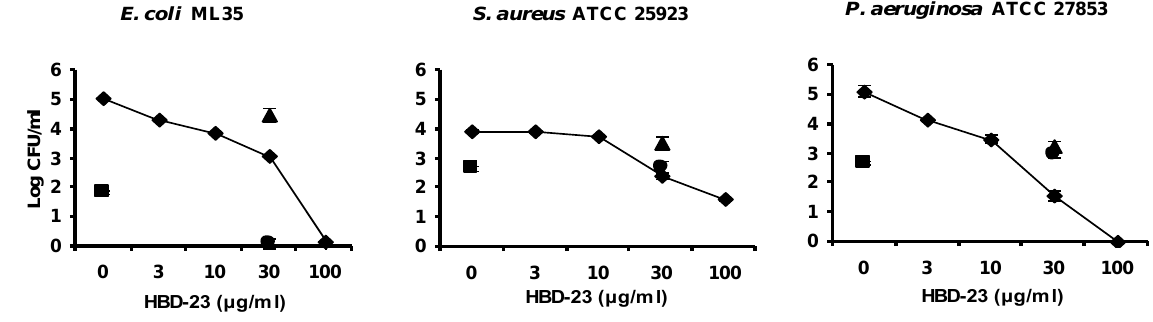
Figure 4. Antimicrobial activity of HBD-23 against three bacterial species. The antimicrobial activity of HBD-23 was evaluated by colony forming unit (CFU) assay and plotted on a logarithmic scale. The experiments were carried out using four different concentrations of HBD-23 (3 μg/mL, 10 μg/mL, 30 μg/mL, 100 μg/mL) with 20 mM lysozyme (square) as the positive bactericidal control. The bactericidal activity of 30 μg/mL HBD-23 was also tested in the presence of 150 mM NaCl (triangle) and 2 mM dithiothreitol (circle). The bacteria used were Escherichia coli ML35, Staphylococcus aureus ATCC 25923, and Pseudomonas aeruginosa ATCC 27853. The results shown are the average of three complete experiments with E. coli , five with S. aureus and five with P. aeruginosa; while some points on the graphs represent more experimental repetitions. Error bars show standard